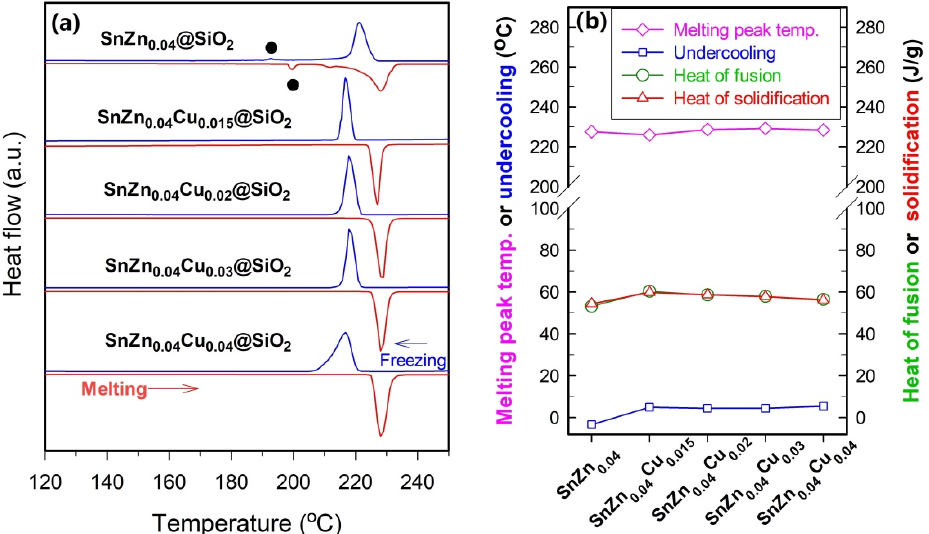
Figure 7. DSC curves ( a ) and phase change properties ( b ) of SiO 2 -encapsulated SnZnCu (encapsulation times = 1) of different amounts of Cu. The result obtained from SnZn 0.04 @SiO 2 microspheres is also shown for comparison.